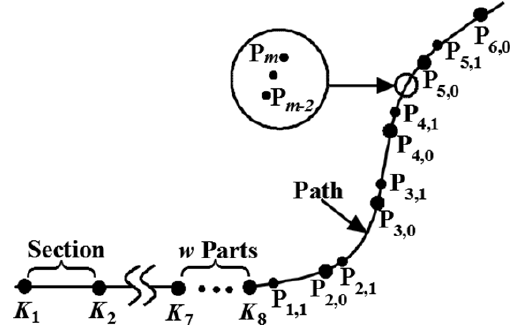
Figure 7. Demonstration of the yardstick